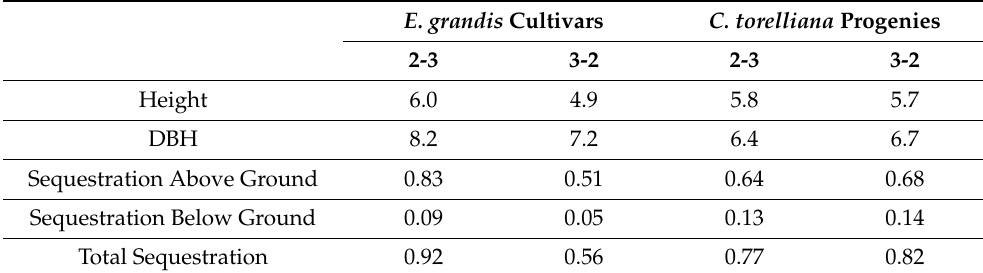
Table 6. Average height (m), DBH (cm), and carbon sequestration (mt/ha) at age 16 months of E. grandis cultivars and C. torelliana progenies in two-row windbreaks in RIBs 2-3 and 3-2.